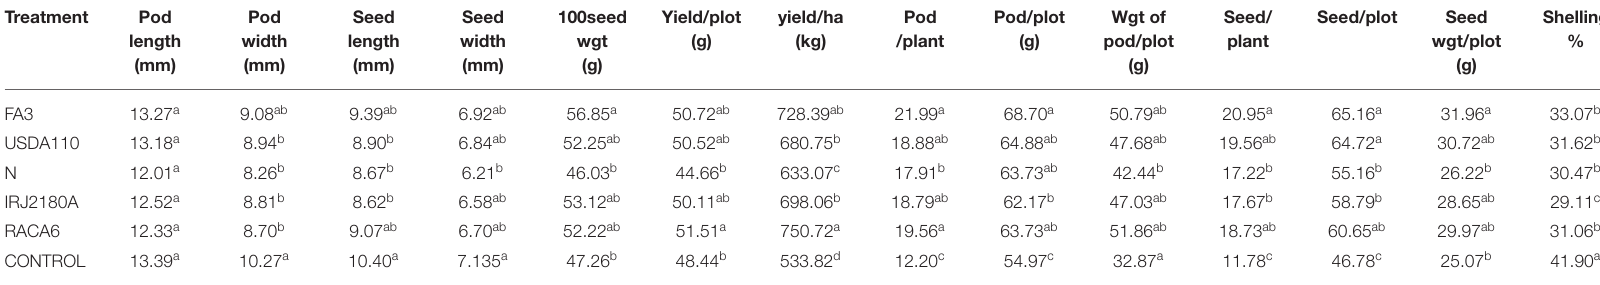
TABLE 10 | Effect of N fertilizer and B. japonicum strains on yield and yield components of Bambara groundnut accessions at harvest in Ibadan and Ikenne during both seasons. Treatment